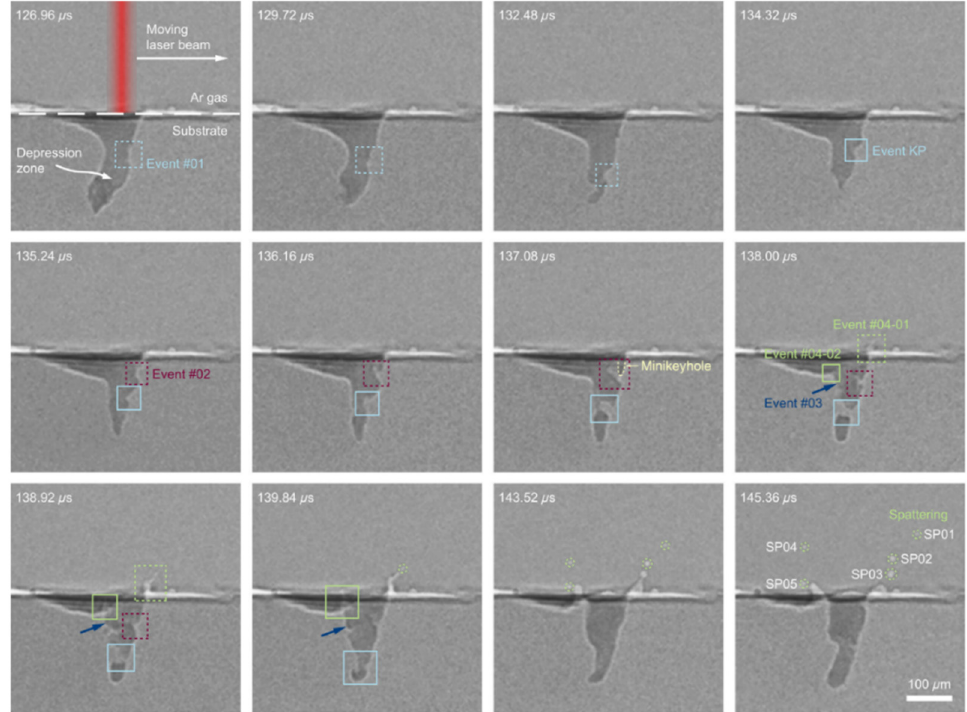
Figure 10. MHz X-ray images of metal spattering of Ti-6Al-4V during laser processing. Event No. 01 (sky blue dashed rectangles): A protrusion forms at the top surface and runs down along the front keyhole wall, accompanied by the keyhole morphology changing from a J-like shape to a reverse-triangle-like shape. Event No. 02 (purple dashed rectangles): A following protrusion appears, grows, and collapses around the horizontal center of the keyhole. A mini keyhole on top of the protrusion is outlined by a light yellow dashed curve. Event No. 03 (dark blue arrows): The local curvature on the rear keyhole wall changes. Event No. 04 (light green dashed and solid rectangles): Melt ligaments form, elongate, and break up into spatters (light green dashed circles numbered SP01–SP05). Event KP (sky blue solid rectangles): describes the formation and vanishing of a keyhole pore (Reprinted with permission from Ref. [71]. Copyright 2019 APS Physics).